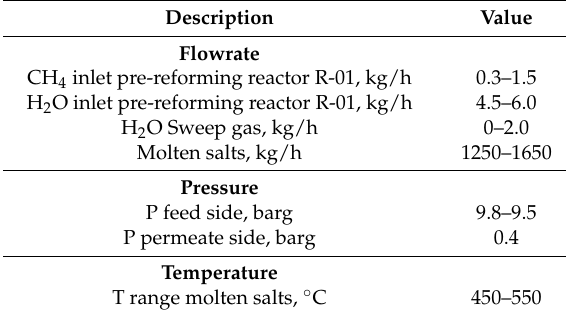
Table 6. Main operating conditions for the integrated membrane